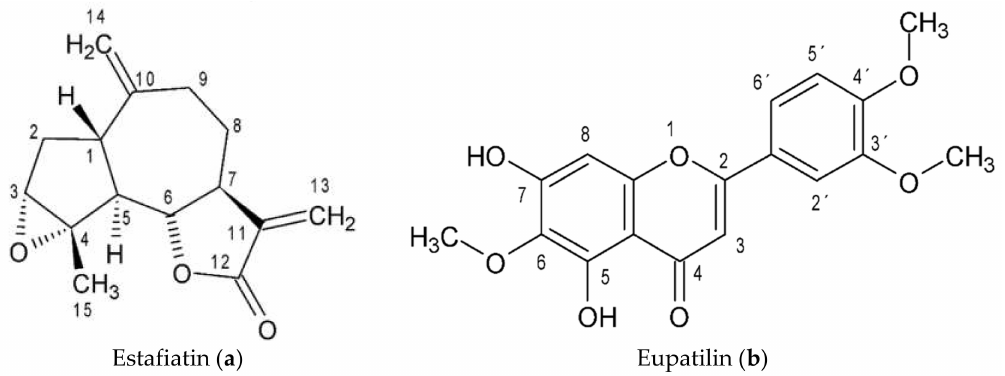
Figure 2. Chemical structures of Estafiatin ( a ) and Eupatilin ( b ).